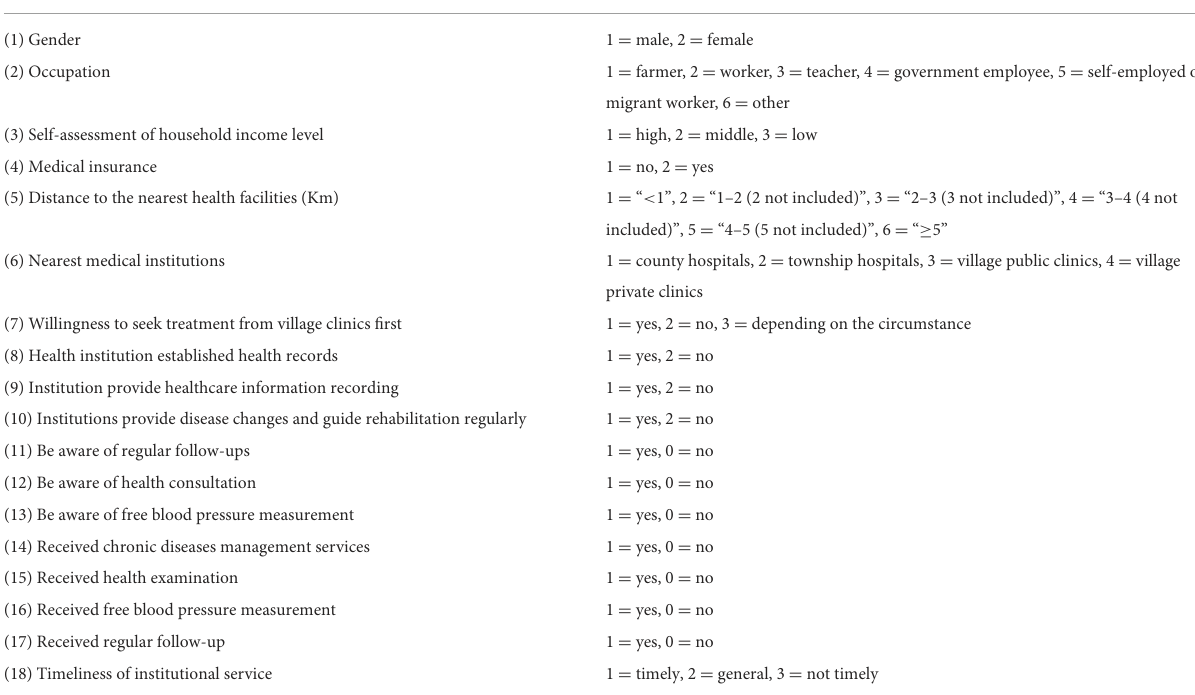
TABLE 1 Definitions of potential